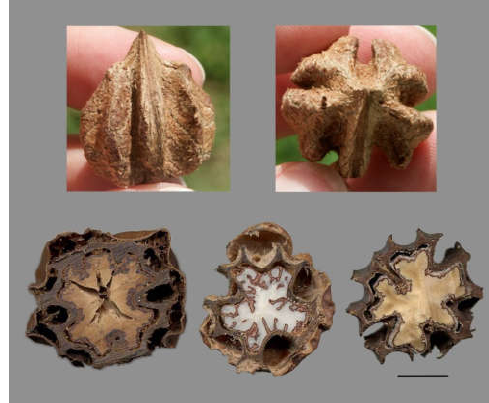
Figure 1. Ptychococcus species owe their name to the morphological properties of their seeds. Ptychos means folding or doubled seed (surface). Images: Ptychococcus paradoxus. Above: Two views of the seed. Below: Transversal sections in three seeds of different origins. Bar represents 1 cm. Photos courtesy of Scott Zona.